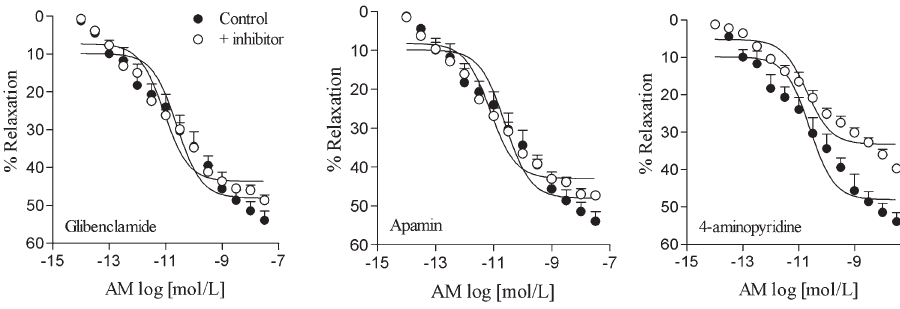
Figure 7. Relaxation responses induced by adrenomedullin (AM) on rat cavernosal smooth muscle strips pre-contracted with phenylephrine. The concentration-response curves were obtained in the absence (control) or after incubation for 30 min with 3 m M glibenclamide, 1 m M apamin, or 1 mM 4-aminopyridine. Data are reported as means±SE of 5 to 6 independent